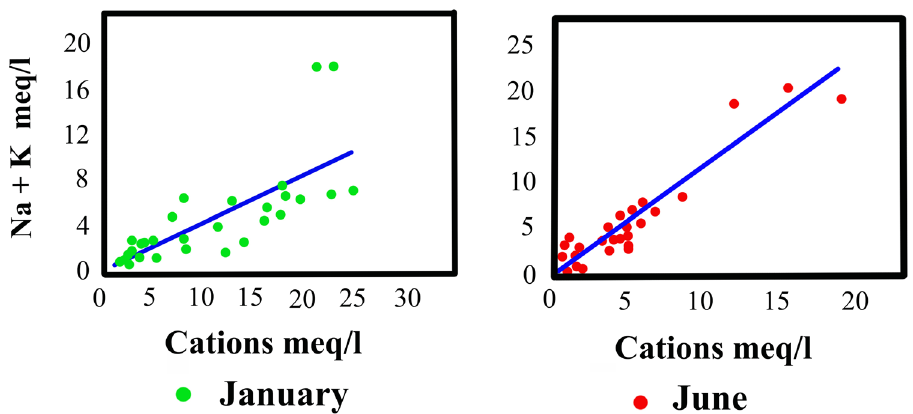
Fig. 11 Na + + K + versus total cation plot for both January and June